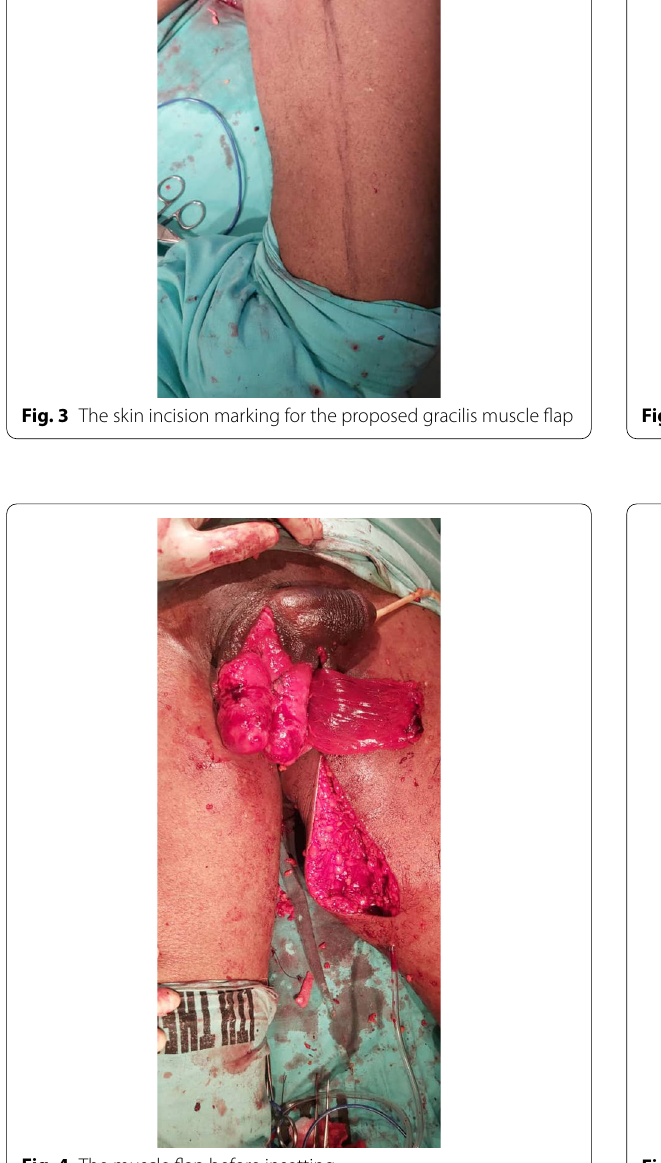
Fig. 6 The fenestrated graft placed on the inset muscle